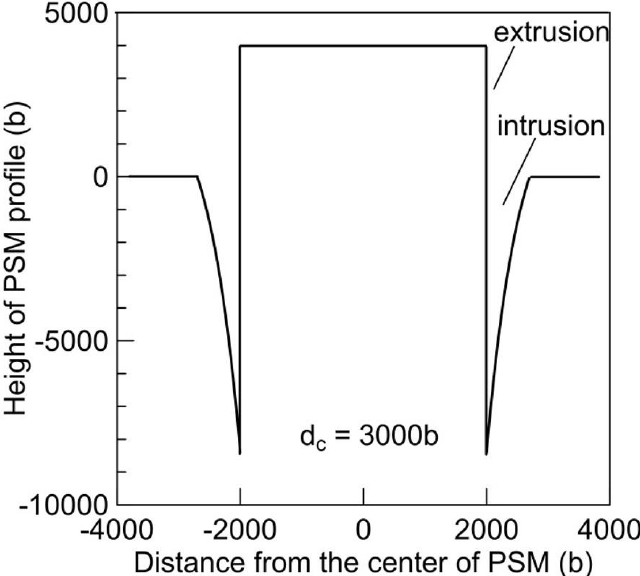
Figure 13. The profile of the central extrusion and two parallel intrusions calculated using Equations (4) and (5) in units of Burgers vector. The height of the extrusion h E = 3000 b and the critical distance d c = 3000 b were chosen. (for copper b = 2.7 × 10 – 10